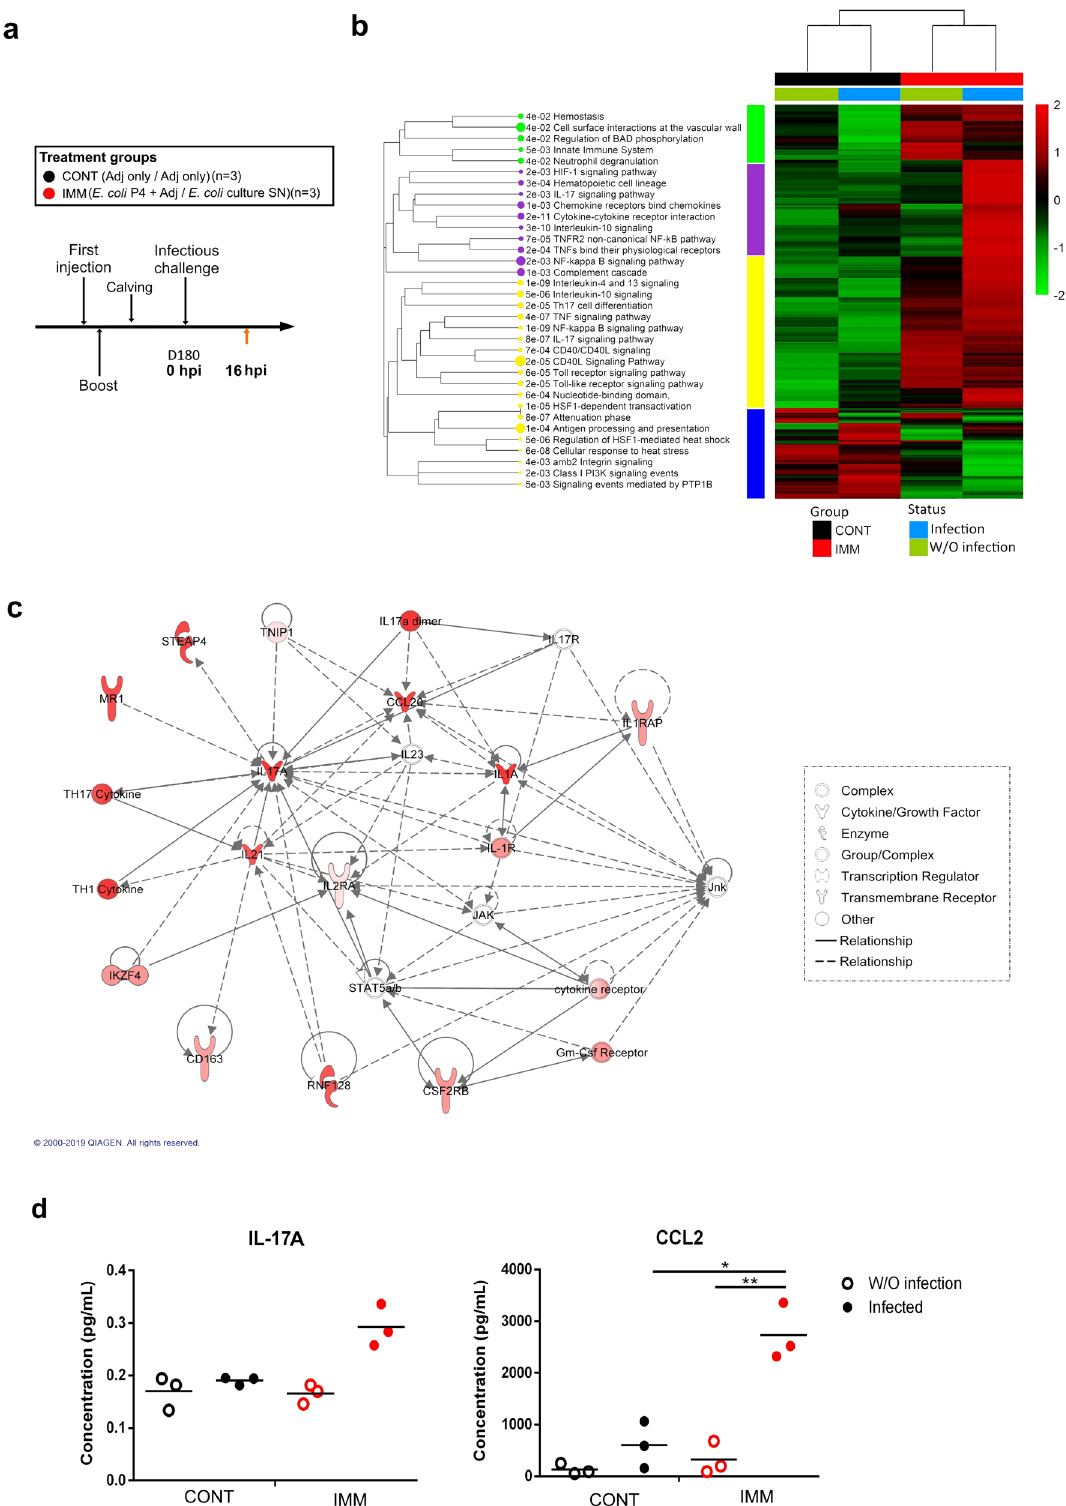
Fig. 6 Gene expression pro fi le of CD4 T cells isolated from the mammary tissue of control and challenged quarters from locally immunized and control cows. a Experimental scheme with immunization and challenge phases. DEGs were assessed between four conditions corresponding to challenged and control quarters in CONT and IMM cows. b A heatmap showing the top 500 DEGs according to the conditions is presented. Functional analysis performed with ToppGene is presented as a dendrogram of functions in each block of correlated genes ( p value < 0.05). c Gene network of the DEGs in CD4 T cells between the infected IMM and infected CONT conditions is presented and shows the relationship with IL-17 cytokine . d Tissue IL-17A and CCL2 production in non-infected and challenged quarters of CONT and IMM cows was determined on a pre-de fi ned amount of tissue homogenate with a Milliplex assay at 16 hpi. Individual values are shown for n = 3 cows per group. Published in partnership with the Sealy Institute for Vaccine